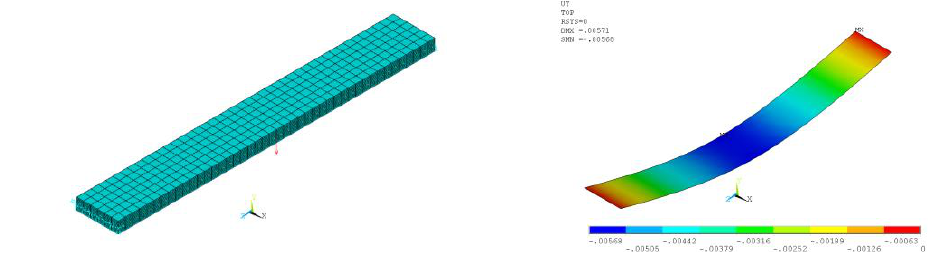
Figure 10. Finite element model of three-point bending of a fiberglass specimen.